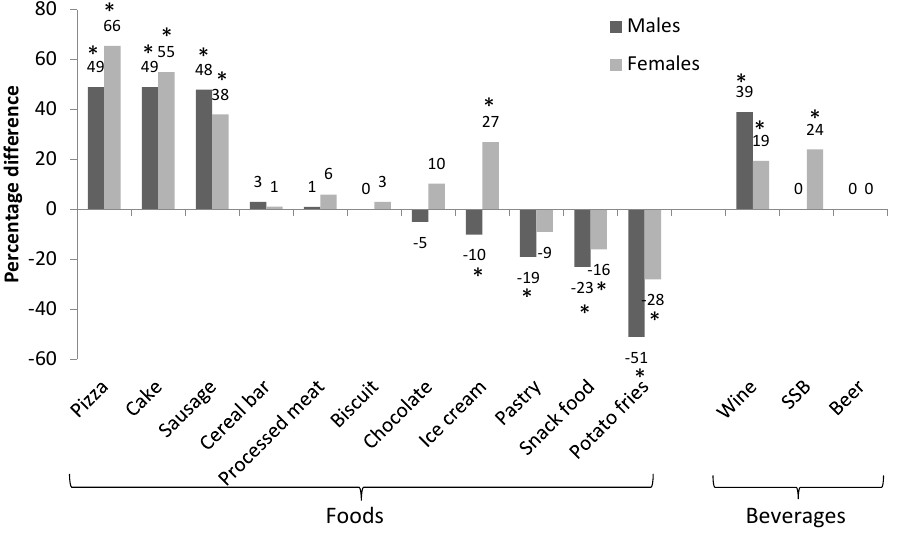
Figure 2: Percentage difference in median portion size (grams) between 1995 and 2011-12 by sex